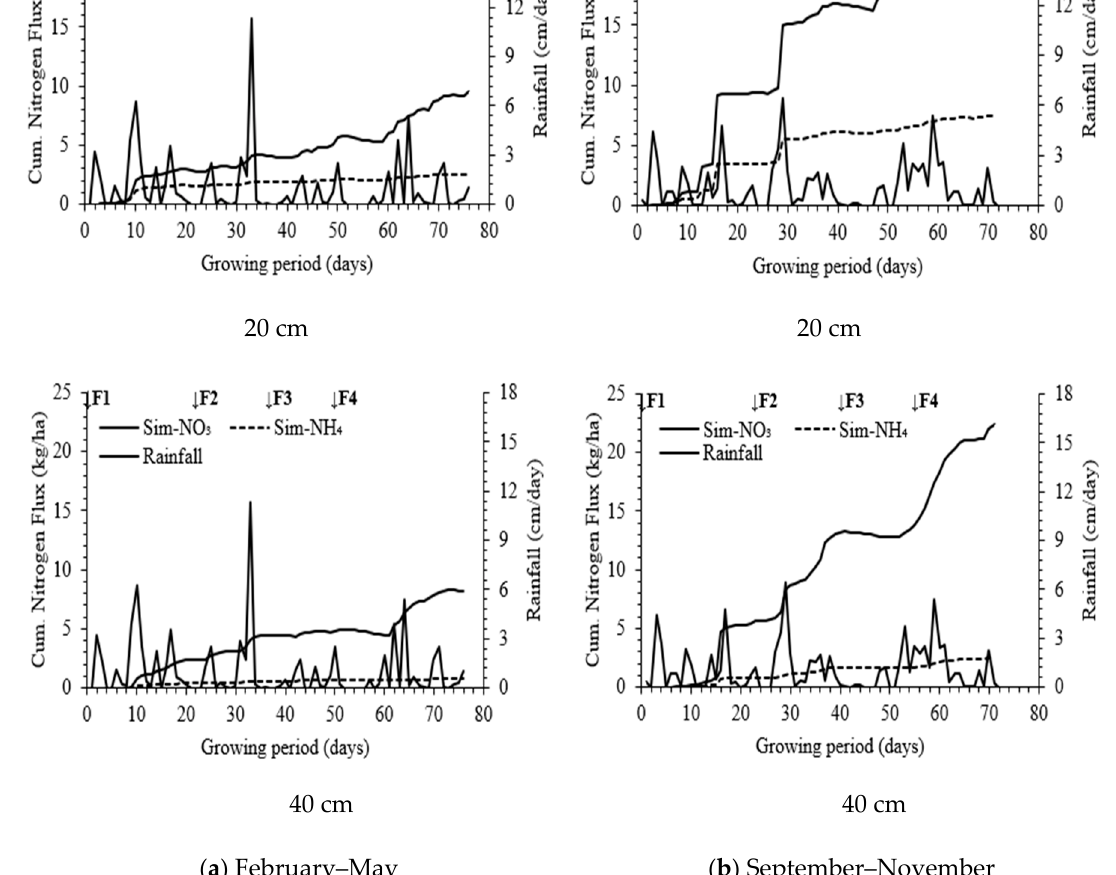
Figure 10. Comparison of simulated (Sim.) cumulative N fluxes at 20 and 40 cm depth during the ( a ) first season and ( b ) second season.